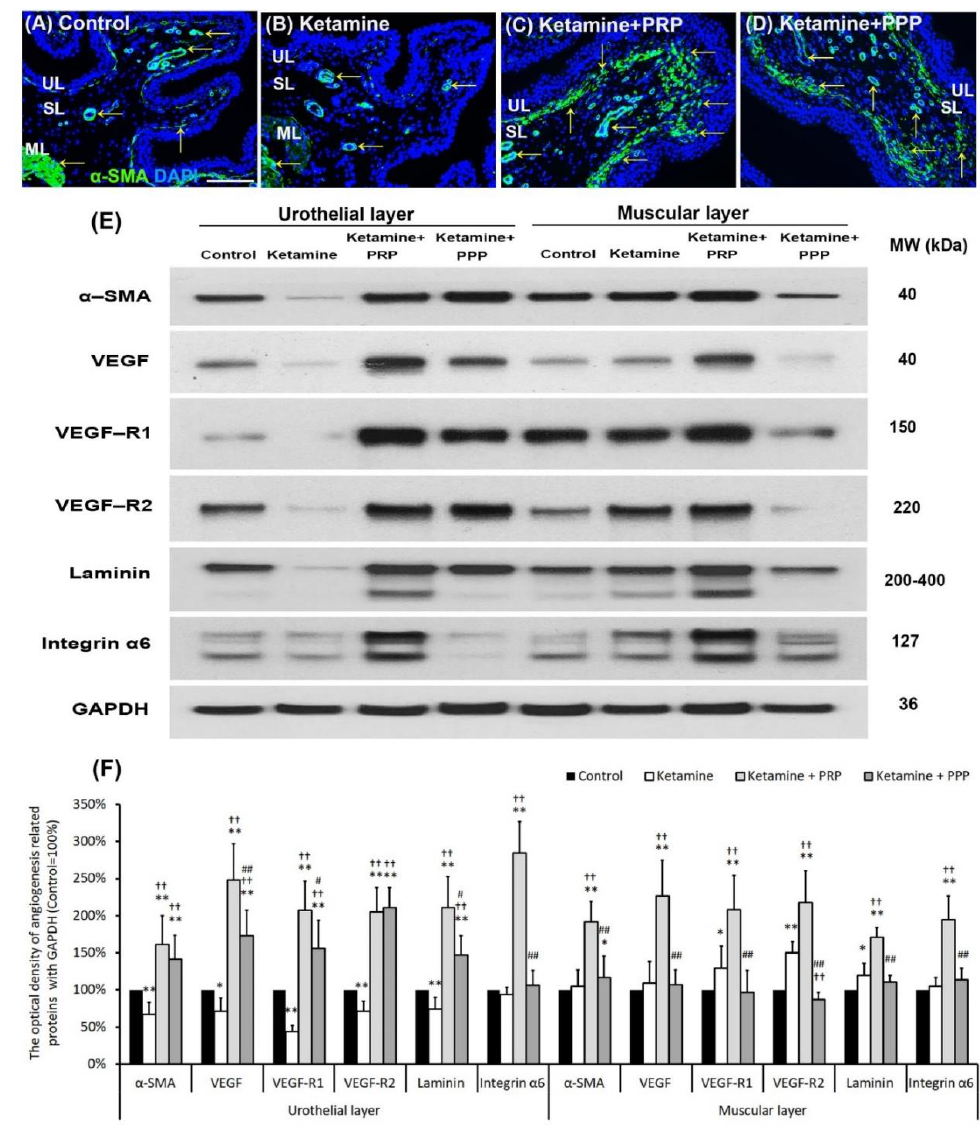
Figure 4. Bladder angiogenic remodeling was triggered by PRP treatment. The angiogenesis markers were analyzed by immunostaining ( A – D ) and western blotting analysis ( E , F ). ( A – D ) The α -SMA immunostaining was widely expressed in smooth muscle of microvessels beneath urothelial basal layer and vessels in suburothelial layer (SL) and muscular layer (ML) in the control group ( A ). In the ketamine group ( B ), the staining of α -SMA was reduced in the SL compared to the control group. However, the staining level in the ketamine + PRP group ( C ) and the ketamine + PPP group ( D ) were increased in SL and beneath urothelial basal layer compared to the ketamine group. Particularly, the level of the ketamine + PRP group in SL and ML was much stronger than the ketamine + PPP group. ( E , F ): Western blotting analysis was used to quantified the percentage of angiogenesis related proteins, including α -SMA, VEGF, VEGF-R1, VEGF-R2 (VEGF receptors), Laminin and Integrin- α6 (Laminin receptor). The protein concentration in the ketamine group was much lower than the control group. Conversely, the expressions of angiogenesis markers were significantly increased in the ketamine + PRP group when comparing to the ketamine group and the ketamine + PPP group. Therefore, PRP altered bladder angiogenic remodeling. VEGF, vascular endothelial growth factor. Results were normalized as the control = 100%. Data were expressed as means ± SD for n = 6, * p < 0.05; ** p < 0.01 versus the control group; †† p < 0.01 versus the ketamine group; # p < 0.05; ## p < 0.01 versus the ketamine + PRP group.